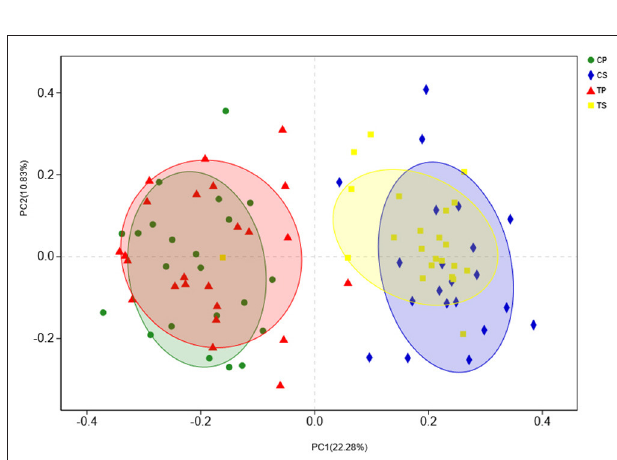
FIGURE 5 | PCoA based on Bray-Curtis distances at the OTU level at 97% identity. Each sample is represented by a dot. Circles in different colors represent different groups. PC1 explained 22.28% of the variation observed, and PC2 explained 10.83% of the variation.